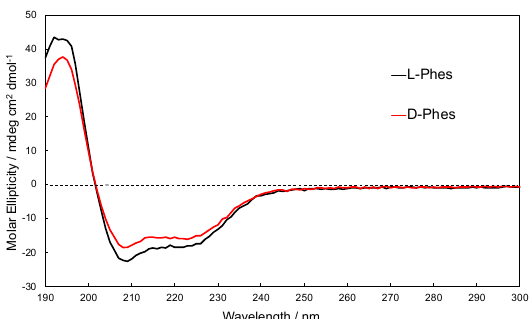
Figure 1. Far-UV CD spectra of L-Phes (black line) and D-Phes (red line) into DMPC/1,2-dihexanoic- sn-glycero-3-phosphocholine (DHPC) bicelles.